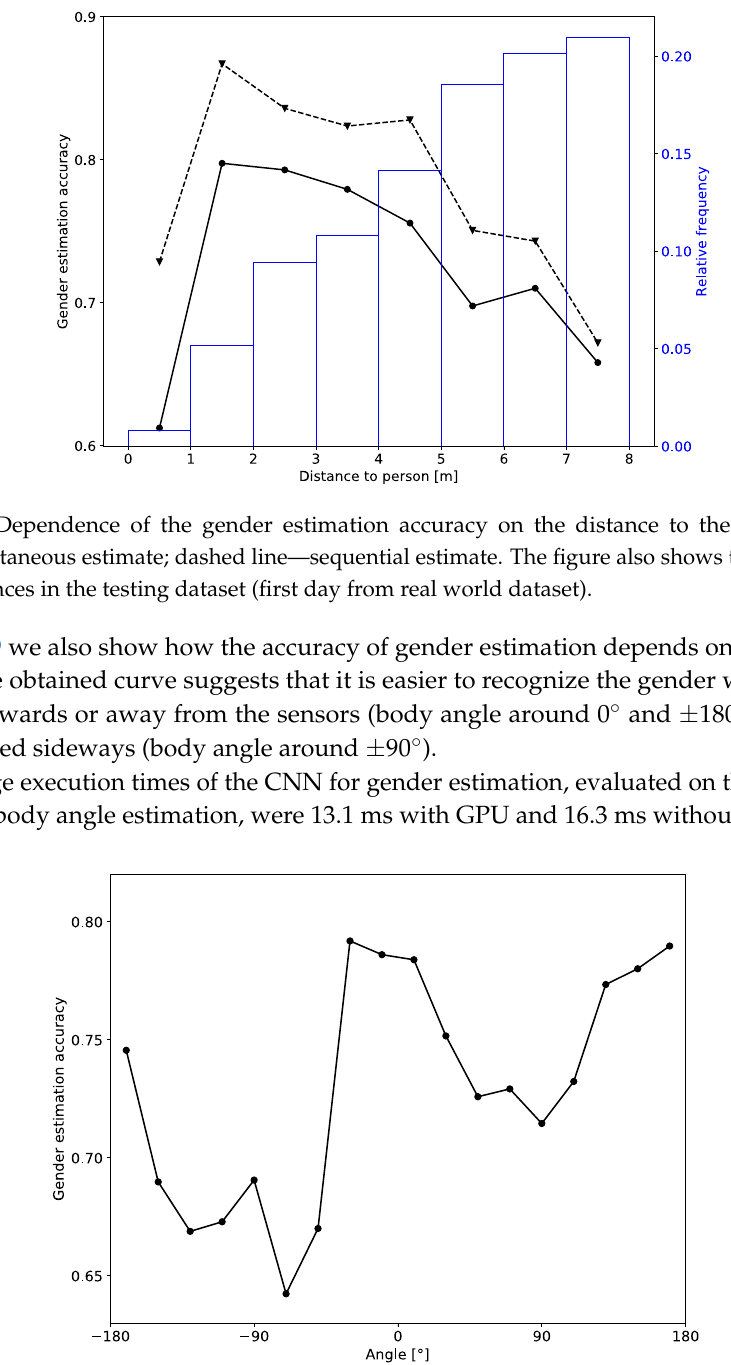
Figure 9. Dependence of the gender estimation accuracy (instantaneous estimate) on the body angle of the